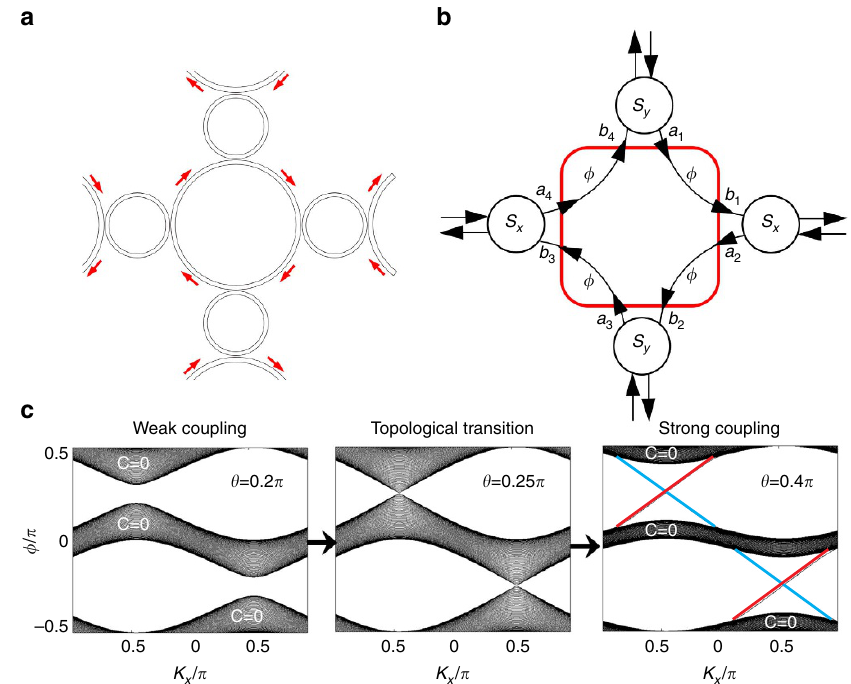
Figure 2 | Network model description of the topological structure and its topological transition. ( a ) Schematic of a unit cell in a two-dimensional lattice of coupled ring waveguides. ( b ) The equivalent periodic network. Within the unit cell, we define a surface (red rectangle) which is penetrated by input amplitudes | a i and output amplitudes | b i , related by | b i¼ e (cid:2) i f | a i . These amplitudes also scatter with those of neighbouring cells, with coupling matrices S x and S y . ( c ) Topological transition as the inter-ring coupling strength y is tuned from weak to strong. Before and after the transition, all bands have zero Chern number C ¼ 0. Red and blue lines denote edge states confined to the upper and lower edges of the strip, respectively.